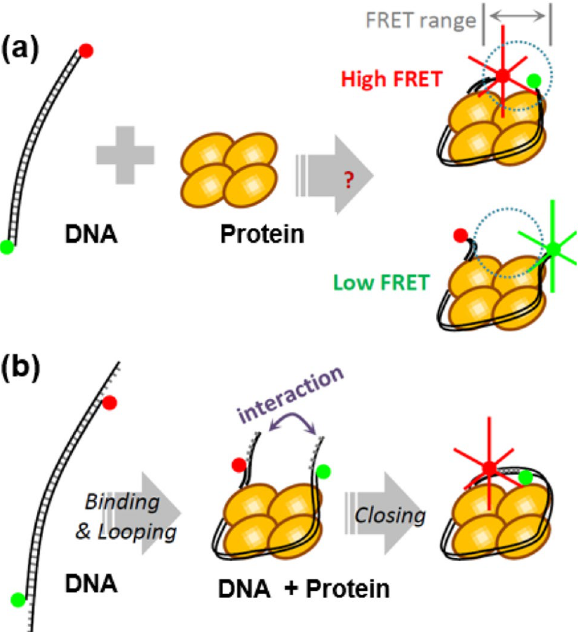
Figure 1. Schematic assay for the single-molecule cyclization ( a ) in the absence, and ( b ) presence of single strand (ss) tail. In ( a ), there is no guarantee to have high-FRET signal from the dye pairs labeled at the two ends of the dsDNA even if the dsDNA makes almost a close